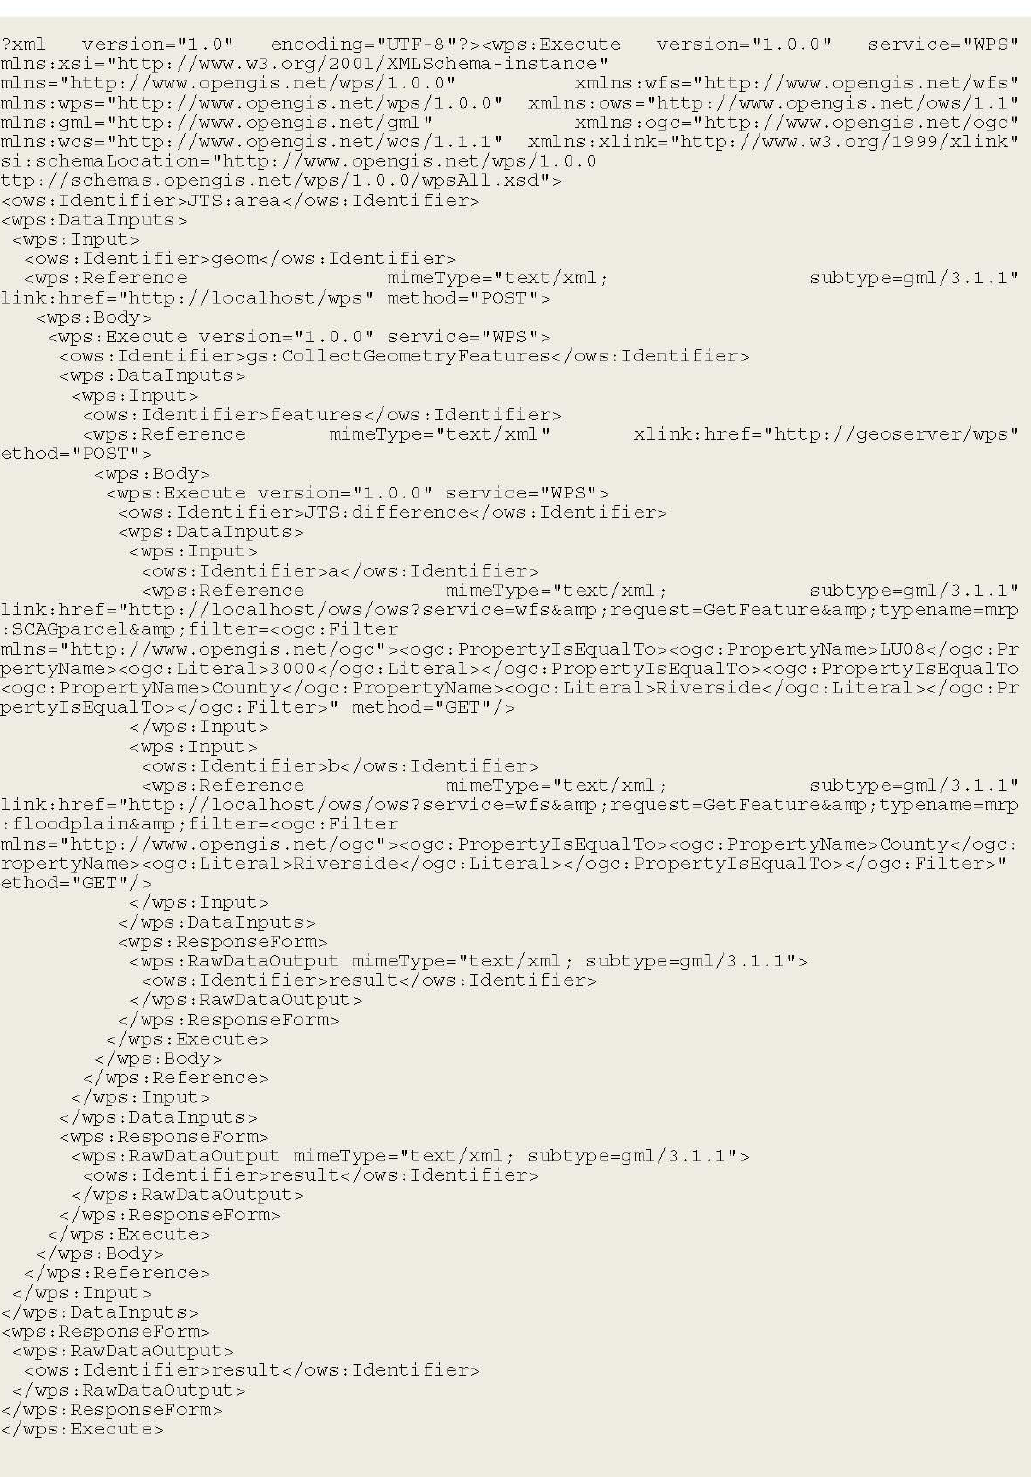
Figure 5. The nested WPS request in XML to answer the question about total developable land area in Riverside County,